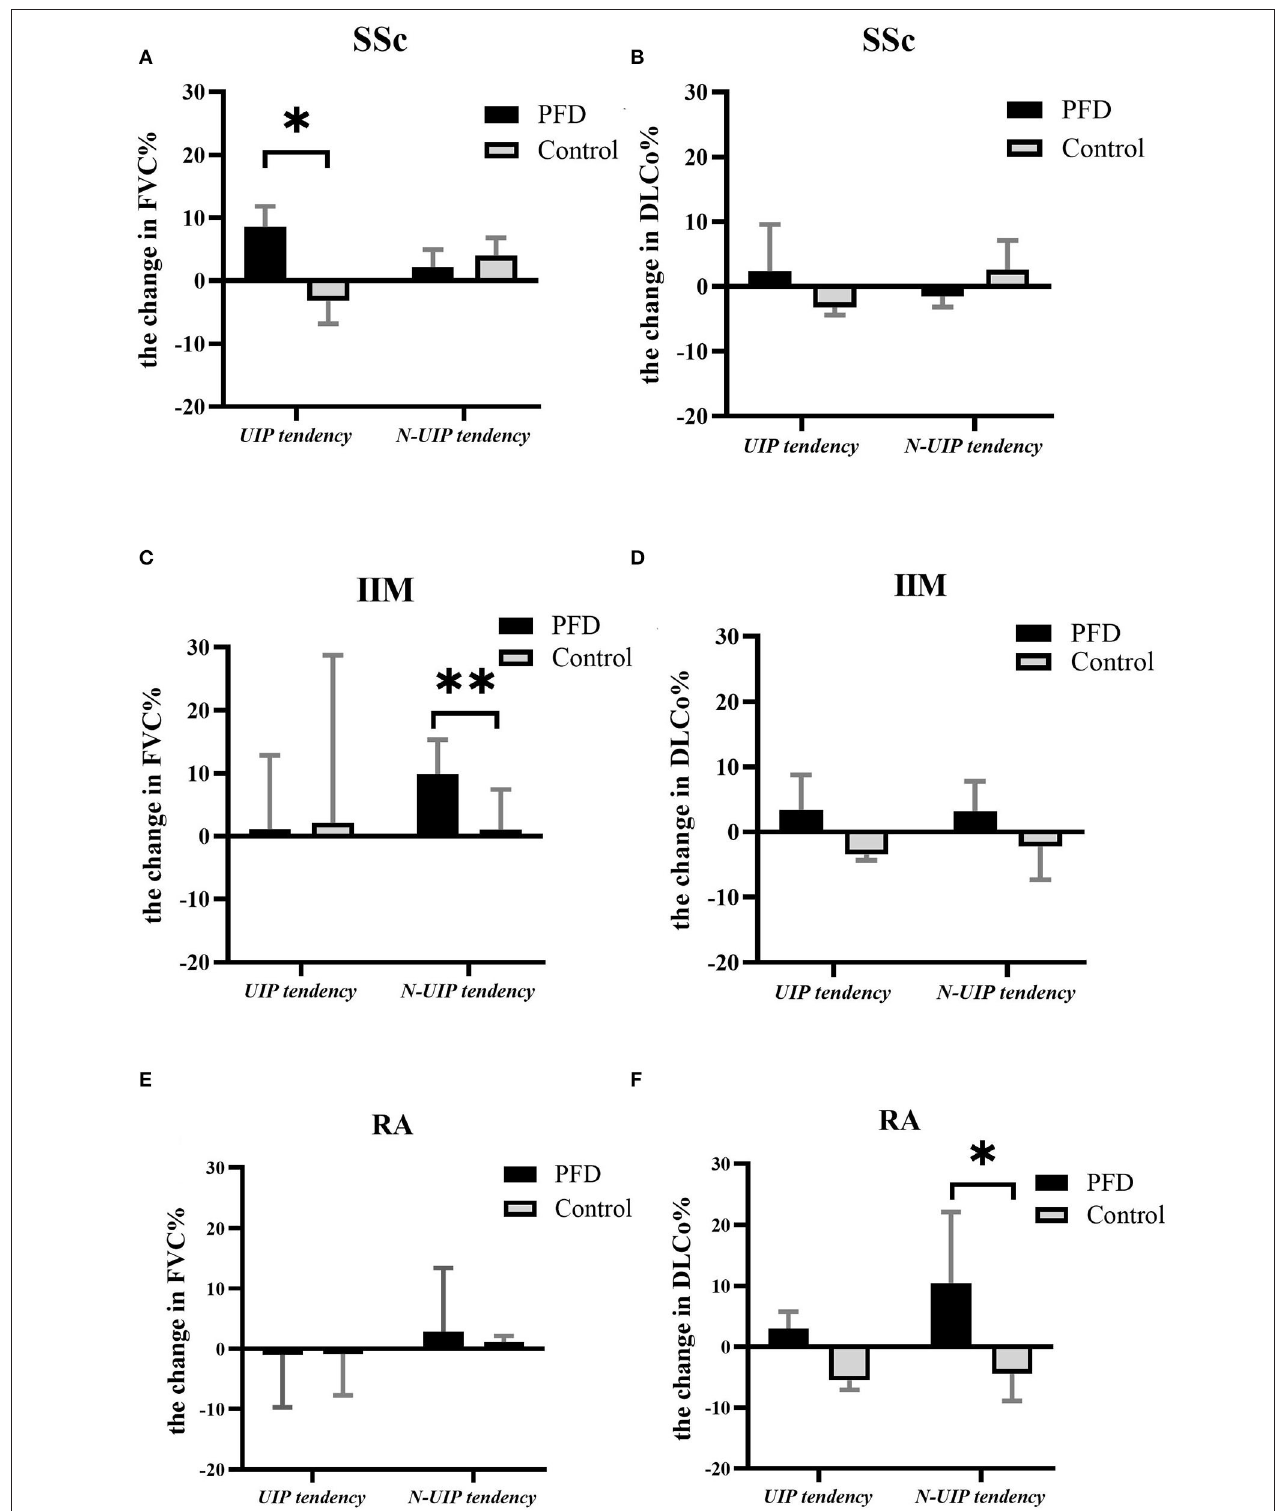
FIGURE 4 | The change in PF in different HRCT subtypes of the 3 CTD-ILD groups with vs. without PFD. The change in FVC% in UIP and non-UIP tendency subtypes of patients with (A) SSc-ILD, (C) IIM-ILD, and (E) RA-ILD and the change in DLCo% in patients with (B) SSc-ILD, (D) IIM-ILD, and (F) RA-ILD either treated or not treated with PFD. * p < 0.05, ** p < 0.01 compared to the no-PFD